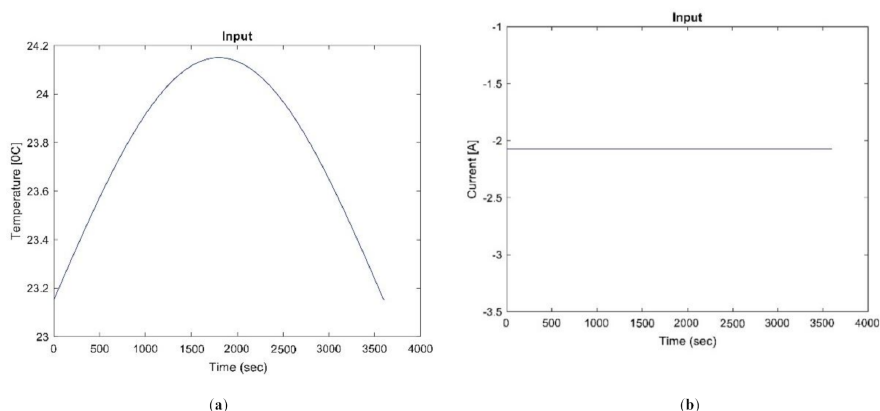
Figure 4. System inputs. ( a ) Temperature input values; ( b ) Current input values. For the outputs of the simulation, after 1-h charging, the SOC reached 90%. As the SOC increased, the terminal voltage increased. As time passed, SOH decreased. Surface and core temperatures of the LiFePO 4 battery changed as they are affected by the ambient temperature and the current. Figure 5 presents these outputs.